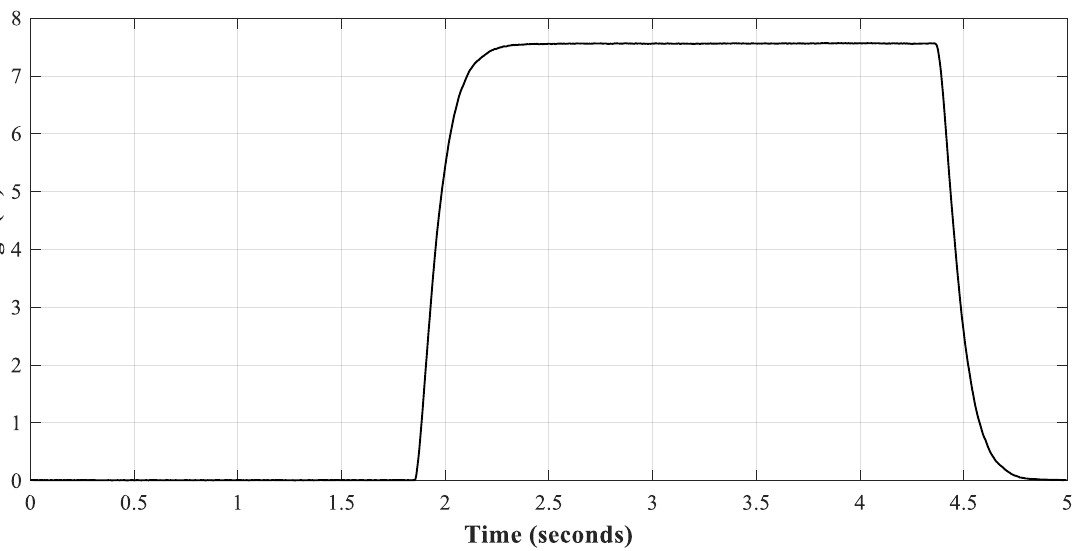
Figure 6. Charging and discharging cycle of electrolytic capacitor.